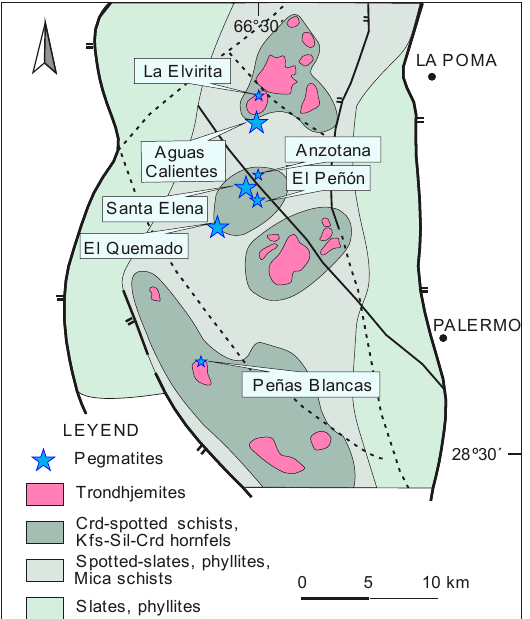
Figure 2. Geological map of the El Quemado pegmatite district with the main Li-bearing pegmatites (modified from [14]). (modified from